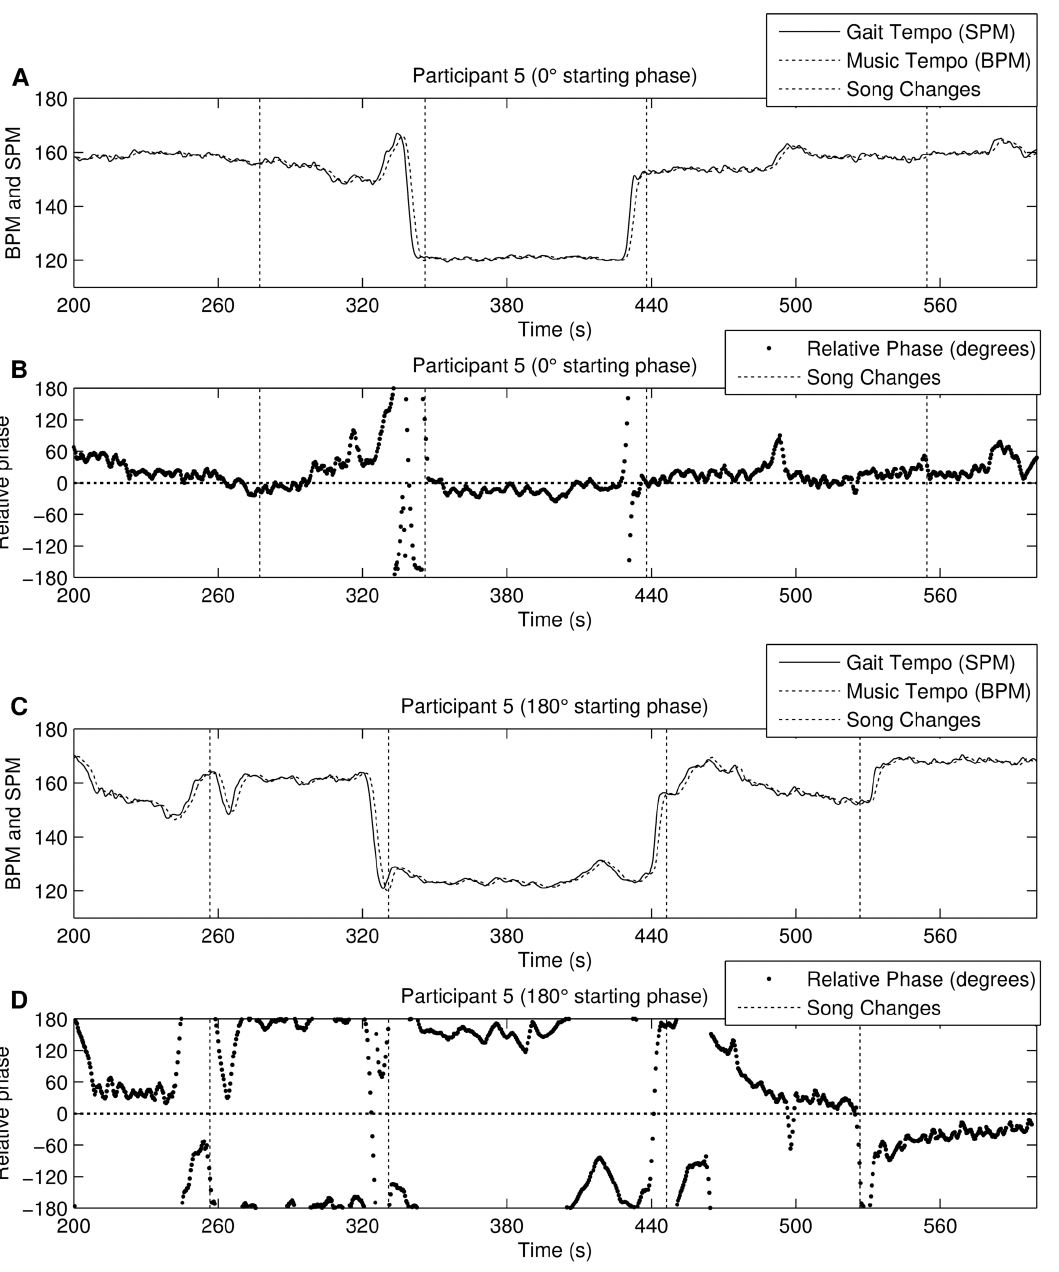
Fig. 11. Excerpts from the same participant using alignment strategy 3 (period-adaptive phase-starting). A and B show the 0 0 starting phase, C and D show the 180 0 starting phase condition from the experiment using the phase-aware stimuli. Figures A and C show tempo plots, figures B and D show the phase evolution per step. The examples show the influence of the starting phase: when starting in sync, the phase lock is mostly maintained while in the offbeat condition, there is a higher chance of deviating from the starting phase towards the 0 0